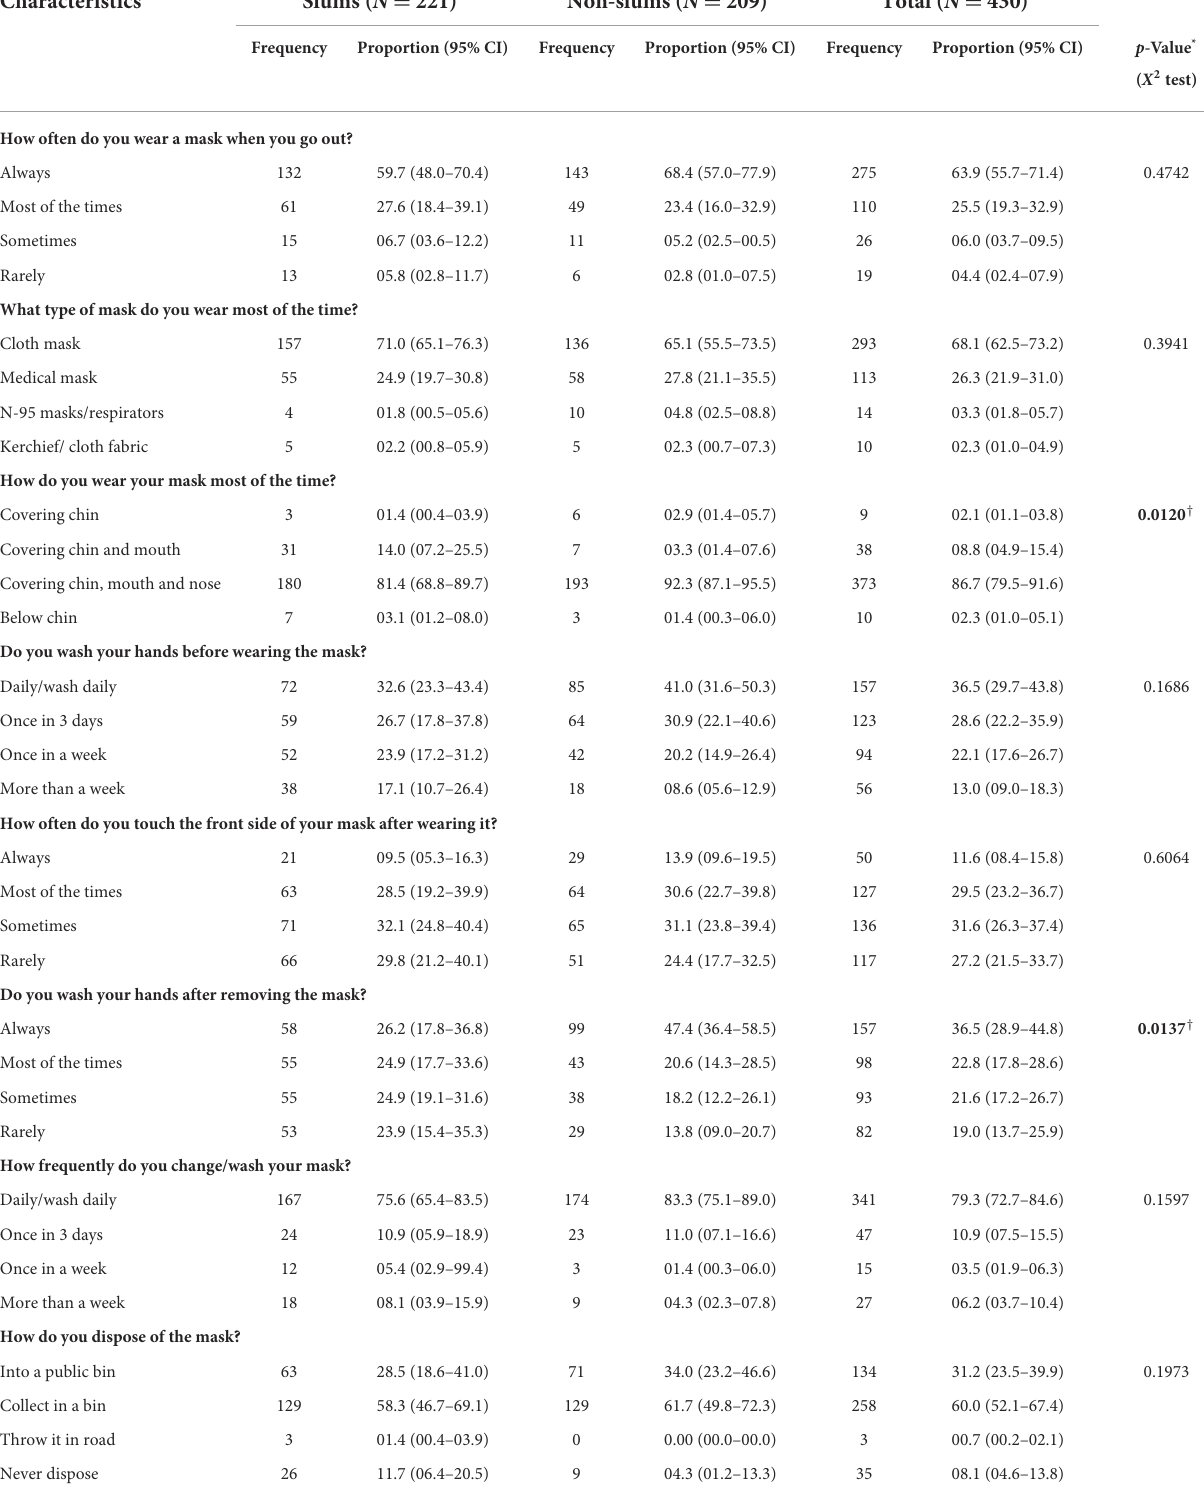
TABLE 4 Practice of Mask use in Public Places among the slum and non-slum population, Greater Chennai Corporation, India, March 2021 ( N = 430).